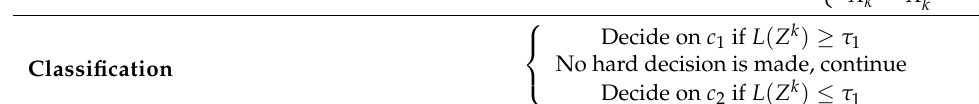
Table 2. EOT algorithm with embedded hard classification.